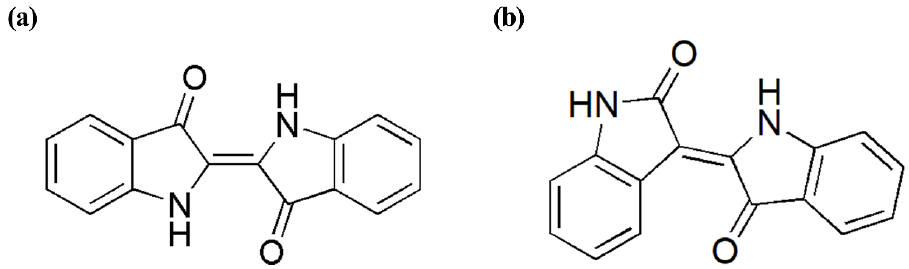
Figure 1. Chemical structures of indigo ( a ) and indirubin ( b ).